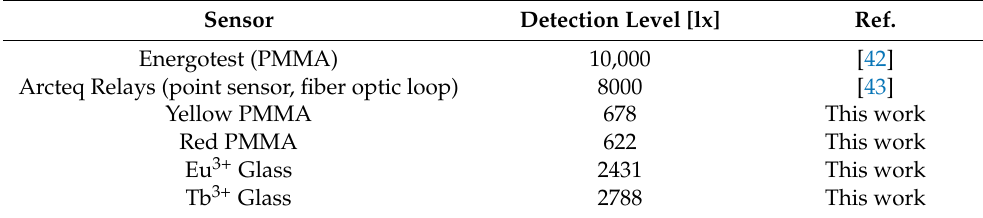
Table 3. The detection level of sensors by diffuse